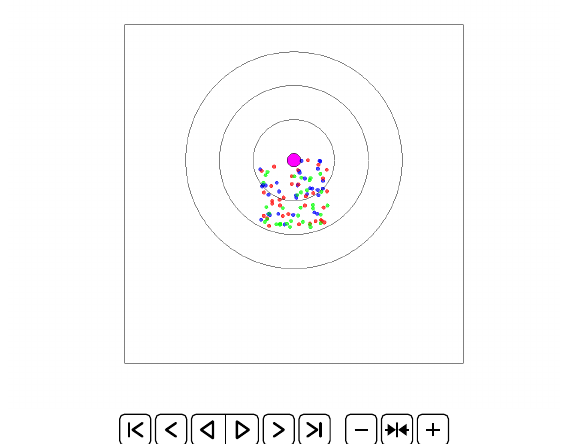
Figure 11. Video of the game when the blood vessel has a high probability of 0.01 per generation of dying and re-merging elsewhere. When neighborless cells can proliferate ( σ = 0.1) and with large zone widths (5 units), extinction never occurred within 5000 generations for any of our replicate runs. The cancer cell populations collapses with the shift in blood vessel location, but quickly recovers. For all replicate runs, one of the cell types would rapidly go extinct (it could be any of the three) while the remaining two would persist through the 5000